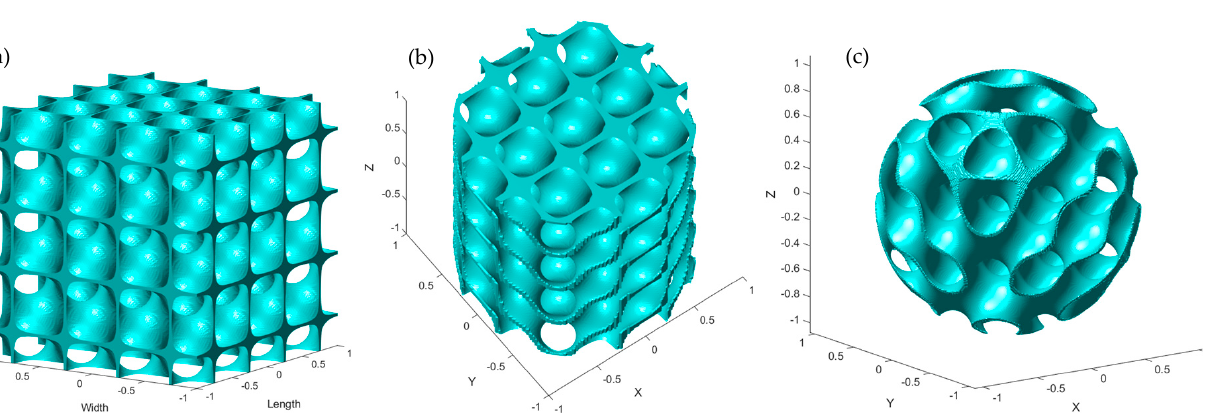
Figure 2. TPMS created on the basis of the Schwartz diamond minimal surface in a limited space: ( a ) cuboid, ( b ) cylinder, ( c ) sphere.